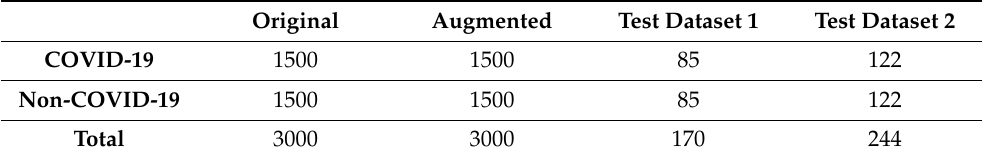
Table 4. Final training dataset with data